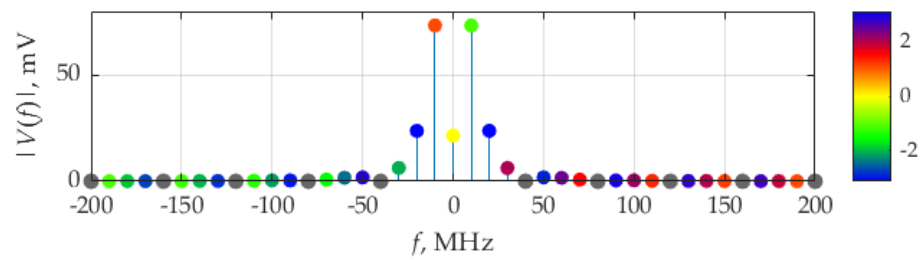
Figure 10. The spectrum of the voltage excited by pulse train current.